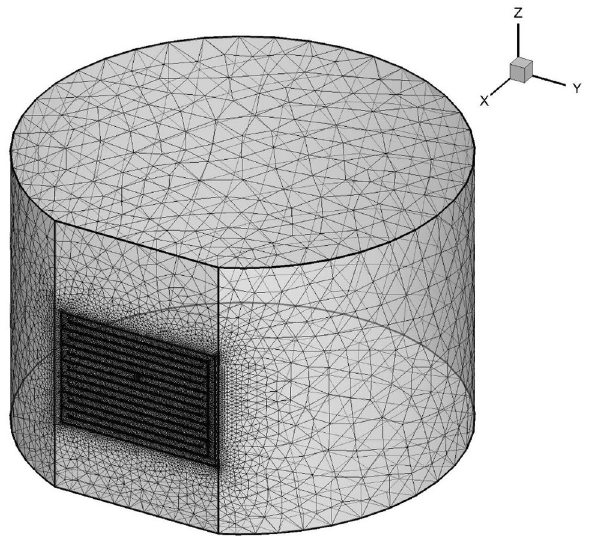
Fig. 4 Generated grid for first step (receiving heat flux) simulation on the boundaries of domain